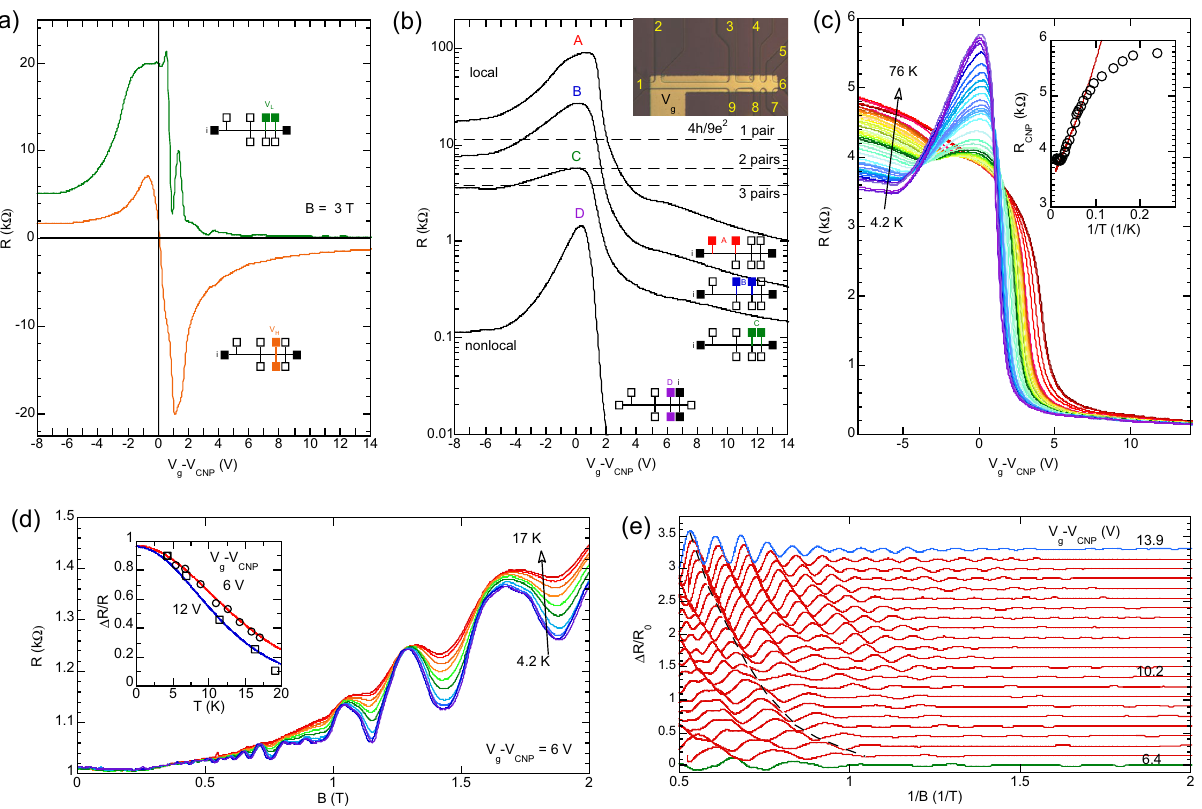
Figure 4. ( a ) Longitudinal (green) and Hall (orange) resistances at B = 3 T and T = 4.2 K as a function of gate bias. ( b ) Local resistance as a function of the gate voltage measured along segments with different lengths (A to C) and nonlocal result (D). Insets show device scheme and measurement configurations. The dashed lines are the expected resistances calculated using Landauer-Buttiker formalism for a device with 9 terminals including the contribution of several pairs of edge states. ( c ) Resistance as a function of the gate voltage for different temperatures. The inset shows the resistance at CNP as a function of 1/T with solid line corresponding to exp (�/ 2 k 0.8 meV. Shubnikov-de Haas oscillations as function of ( d ) R B T ) with an activation energy 64 (cid:31) = ∼ temperature and ( e ) gate voltage. Inset in ( d ) shows the fitting of the amplitude dependence at a fixed magnetic V CNP where the solid line is a fitting using Lifshitz-Kosevich field of 1.2 T for two different values of V g − formula. Curves in ( e ) were vertically shifted for clarity and the dashed line is a guide to the eye for the change in the oscillations phase.